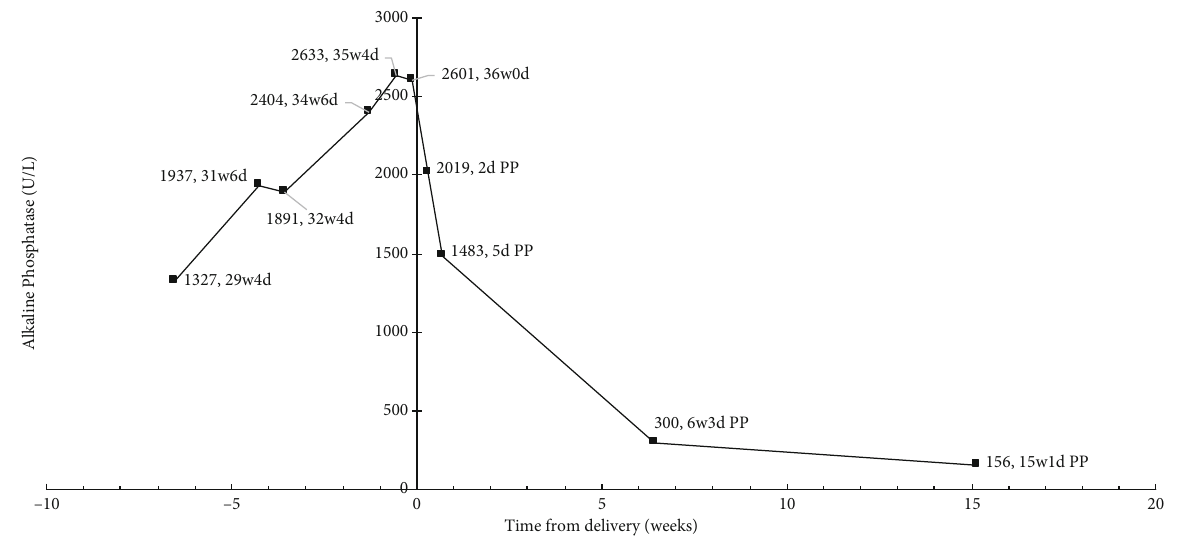
Figure 1: Total alkaline phosphatase levels over time relative to delivery at 36 weeks 1 day. PP: